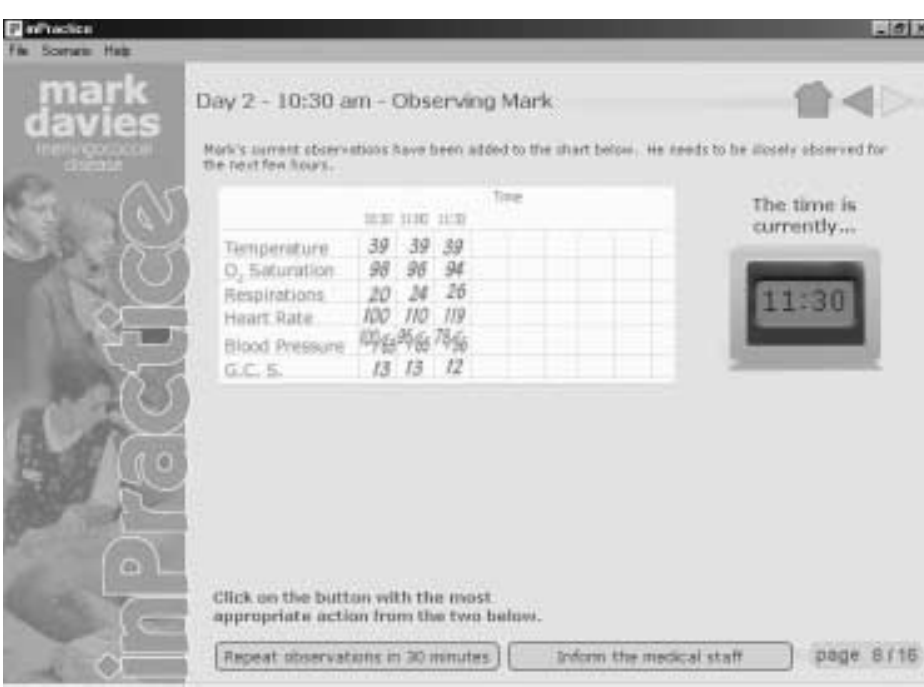
Figure 3. A typical decision screen in an inPractice